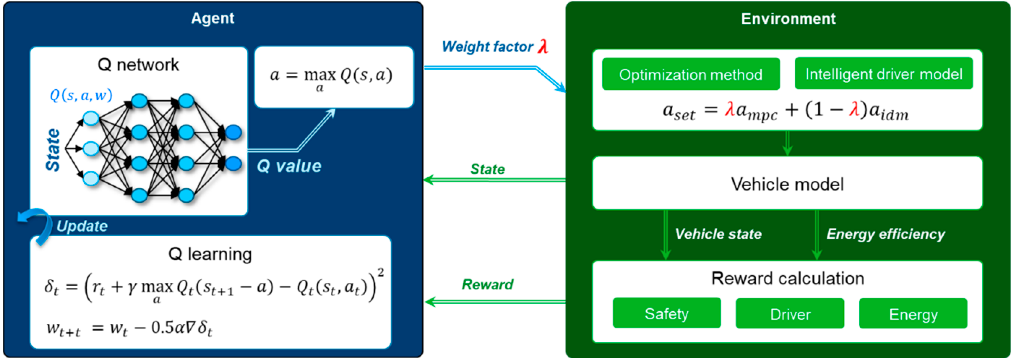
Figure 13. Reinforcement learning for torque control management.